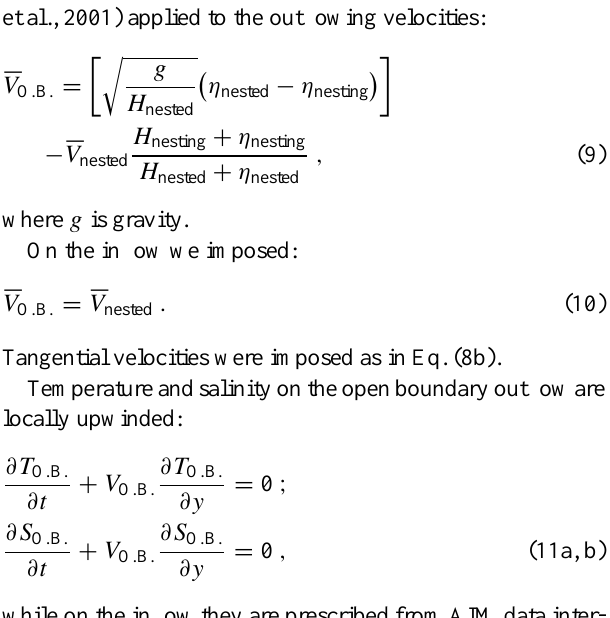
boundary condition for the barotropic velocity, accounting for differences in the surface elevation of the two